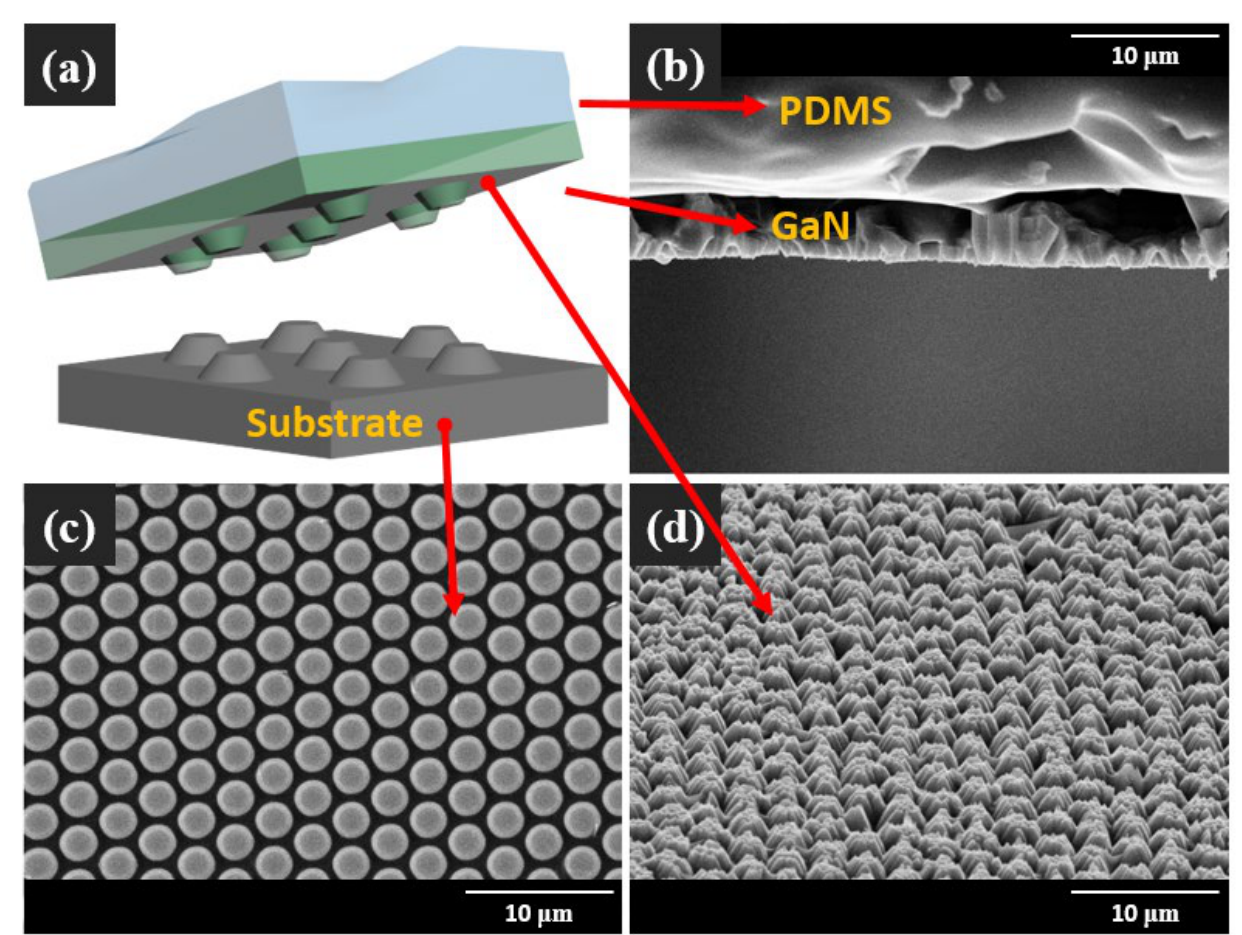
Figure 5. ( a ) Schematic of the CLO process between GaN and substrate with KOH solution, SEM measurements showing each zone after CLO, ( b ) cross-sectional SEM image of GaN film with PDMS, ( c ) top view of the SEM image of the substrate, and ( d ) bird’s eye view of the SEM image depicting the interface between GaN and the